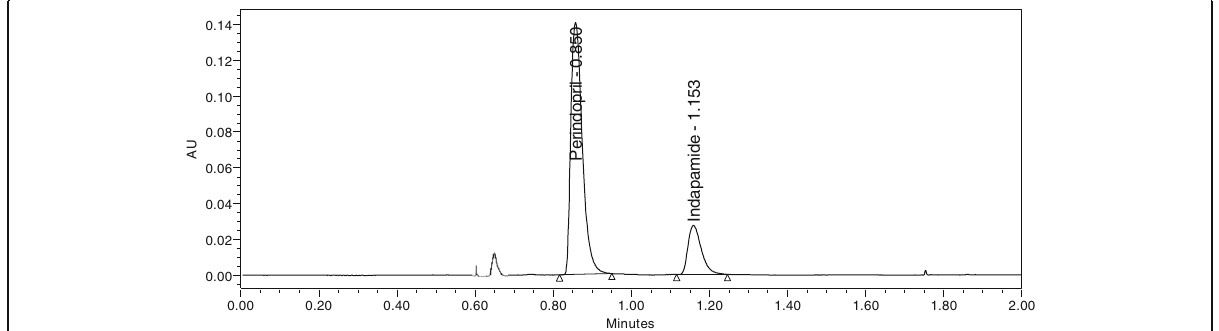
Fig. 3 The final UPLC chromatogram of indapamide and perindopril after the